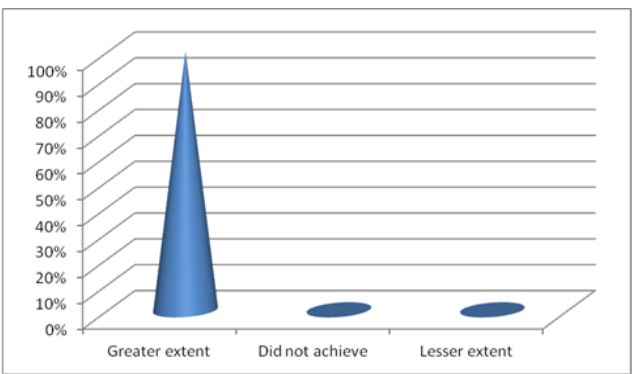
Figure 2: The extent of achieving NSSA’s objectives; Source: Primary